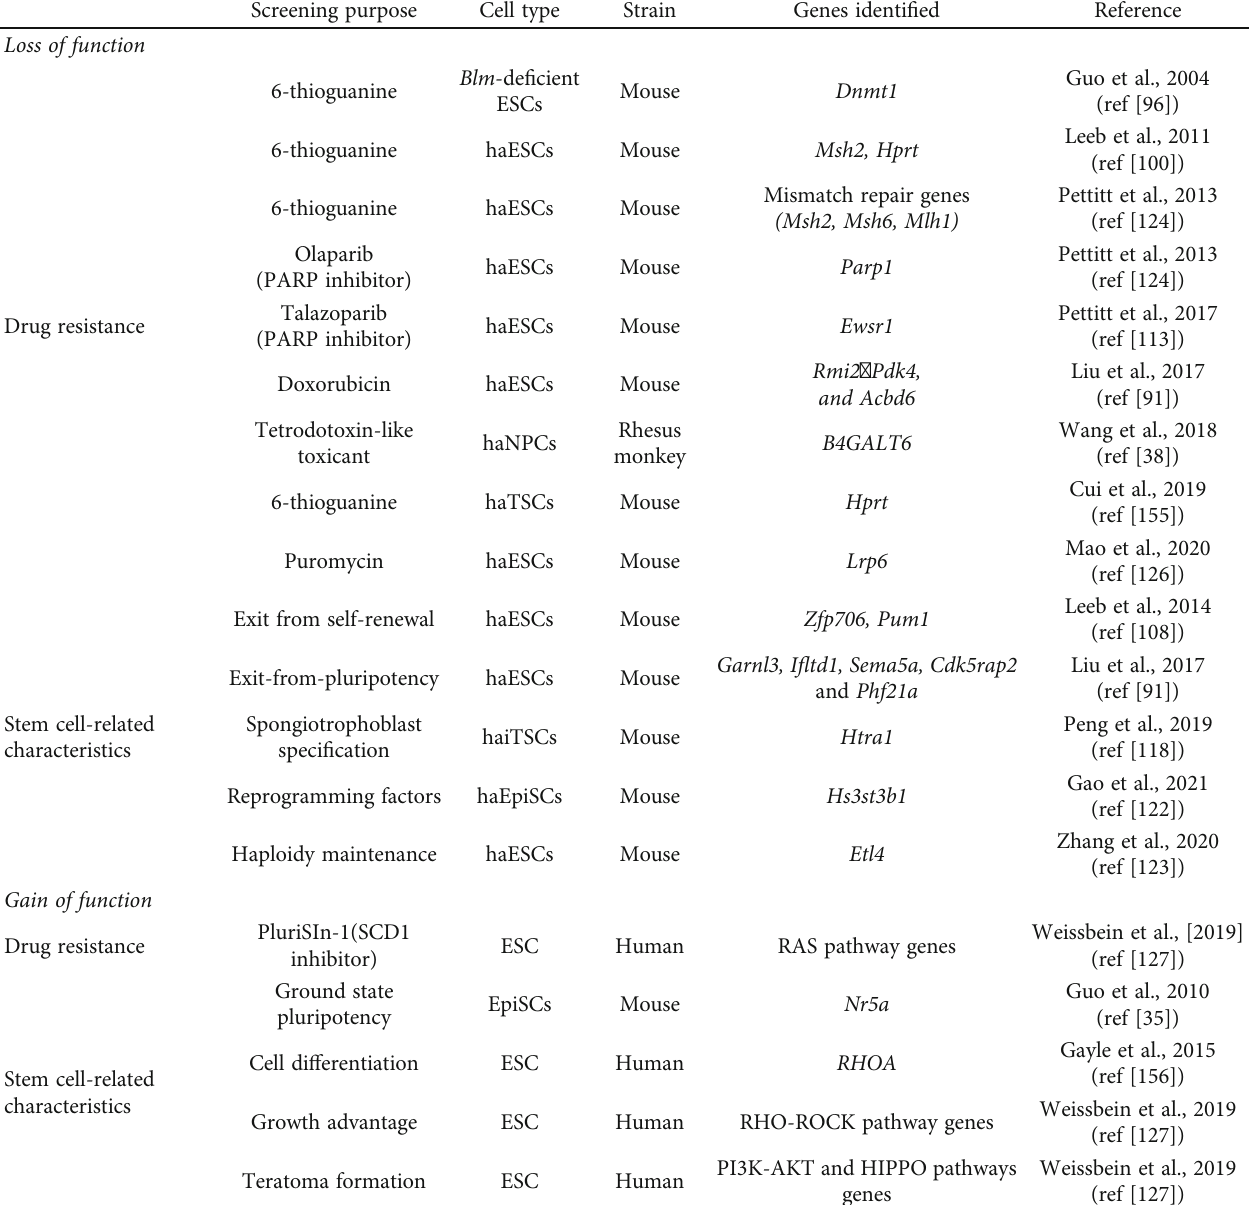
Table 1: Genetic screening using PB